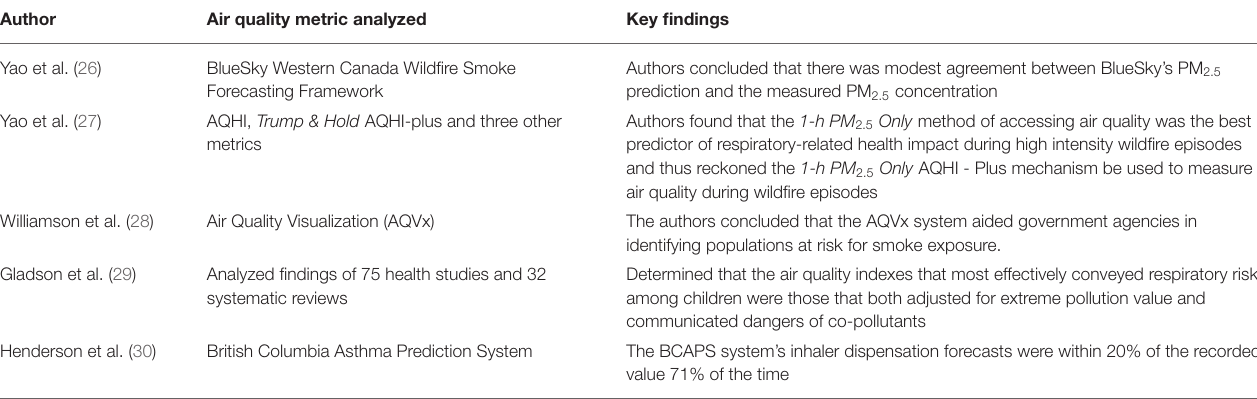
TABLE 2 | Summary of air quality communication studies reviewed (organized chronologically by year